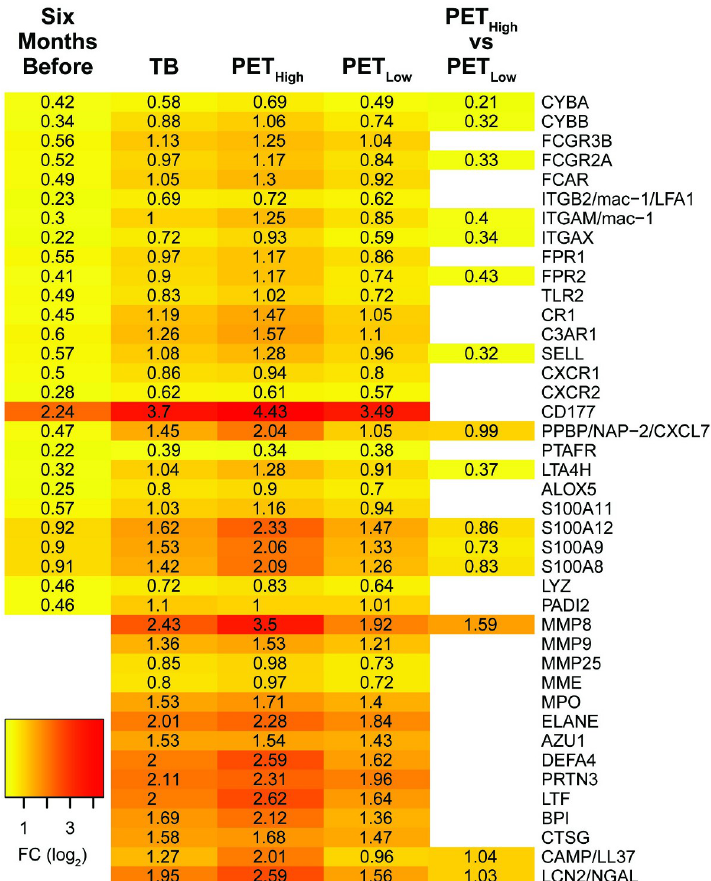
Fig 4. Heatmap of selected annotated neutrophil degranulation genes significantly upregulated 1–6 months before diagnosis and in TB patients. The fold changes presented at 1–6 months before diagnosis (6mBf) are in contrast to the non-TB time zero baseline group from the GC6-74 study. For the TB comparison, the 21 non-TB individuals from the Catalysis study served as controls (see Table 1). Fold-changes for Catalysis TB-patients, categorized with high and low PET scores, were also compared individually to controls and directly to each other to identify differences between the categorized